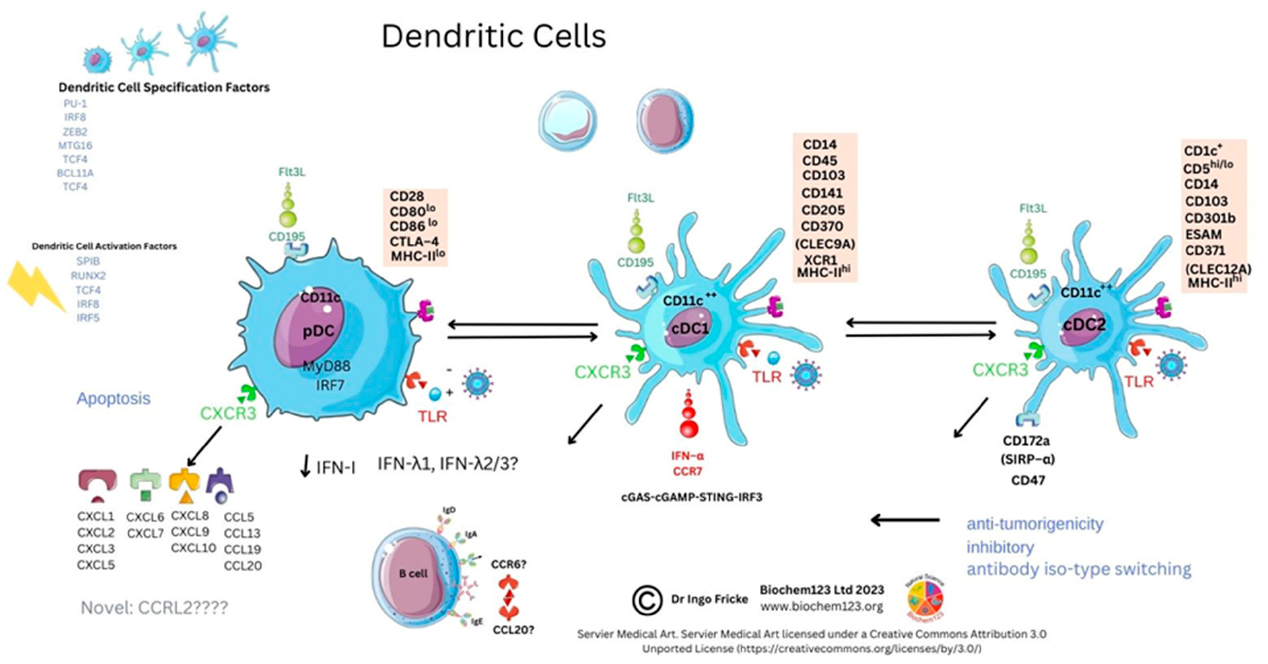
Figure 9. Dendritic cell phenotypes.